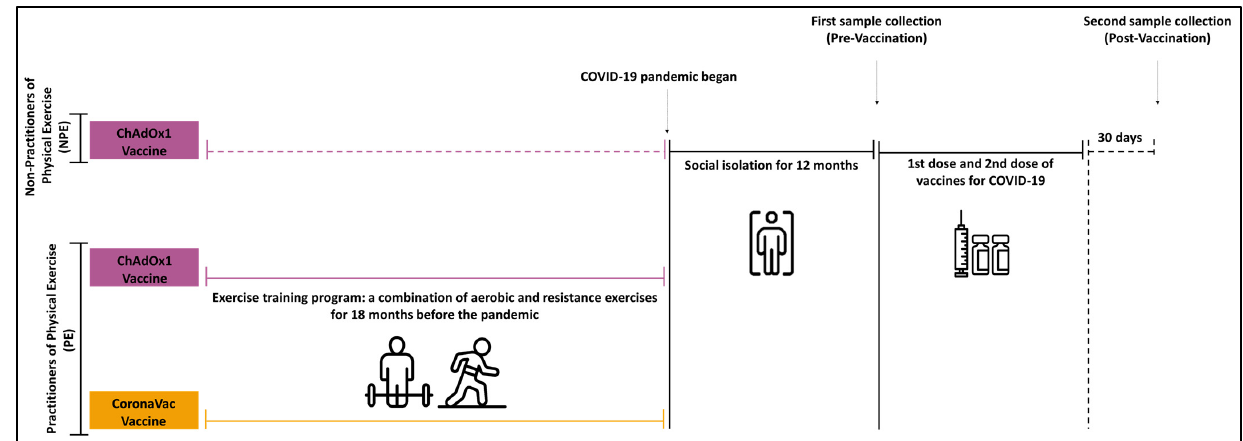
Figure 1. Representative scheme of study design.